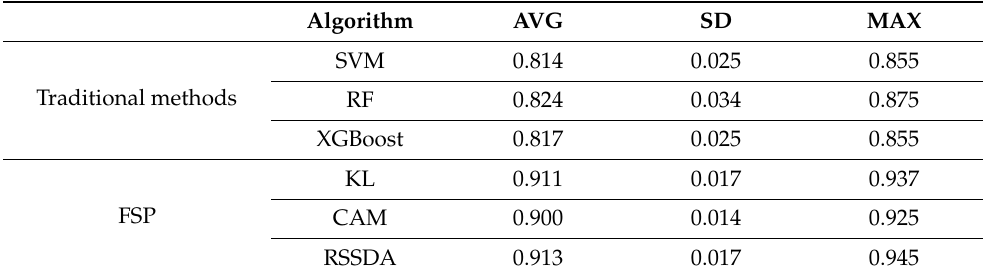
Table 5. The accuracy assessment of ten performances of support vector machine (SVM), random forest (RF), eXtreme Gradient Boosting